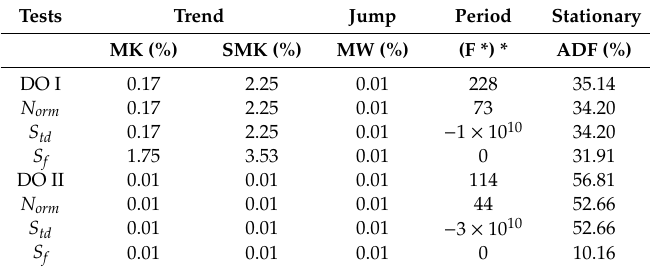
Table 2. Test results of applied tests on DO data and preprocessed outcomes.